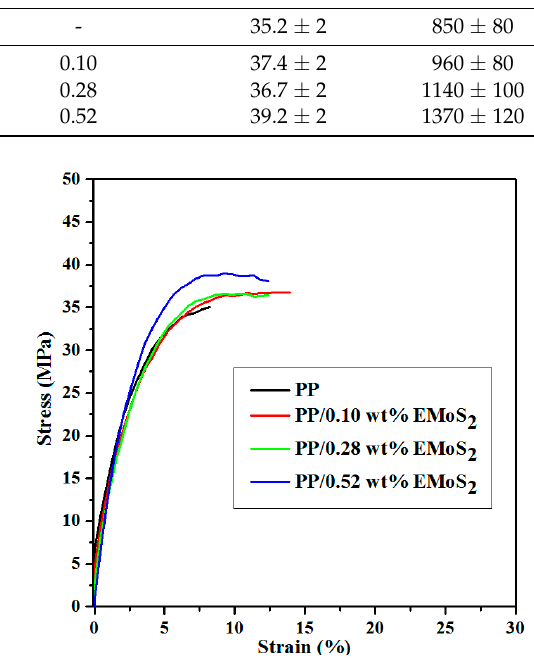
Figure 7. Stress–strain curves of PP and PP/EMoS 2 nanocomposites.